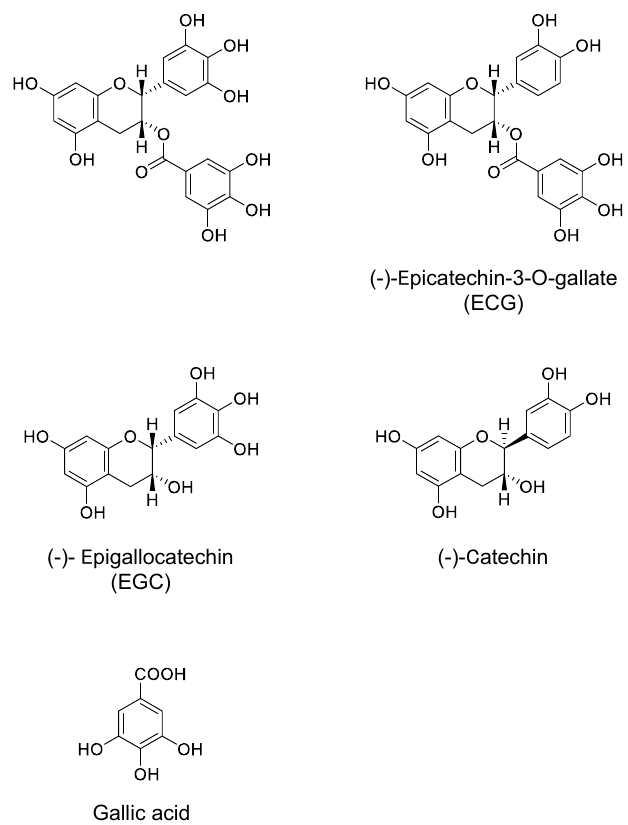
Figure 1. Chemical structure of epigallocatechin gallate (EGCG) and related compounds.